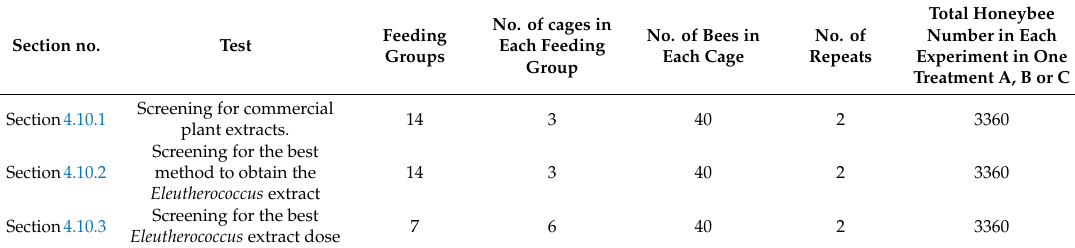
Table 3. The cage tests’ group